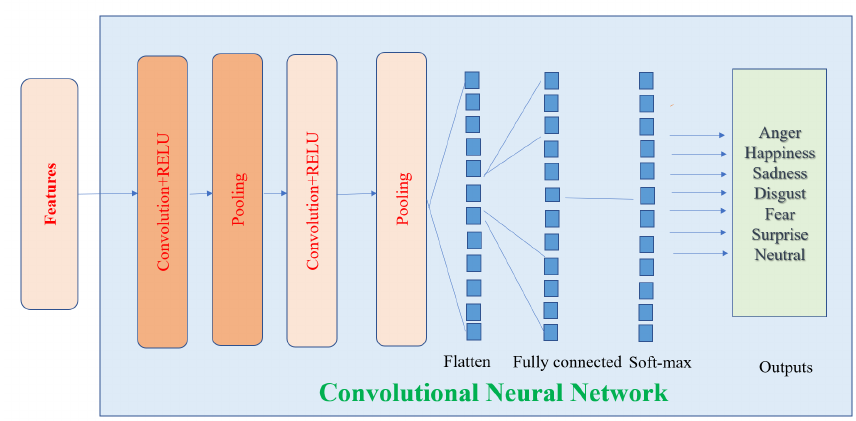
Figure 10. Classification using Convolutional Neural Network (LeNet).